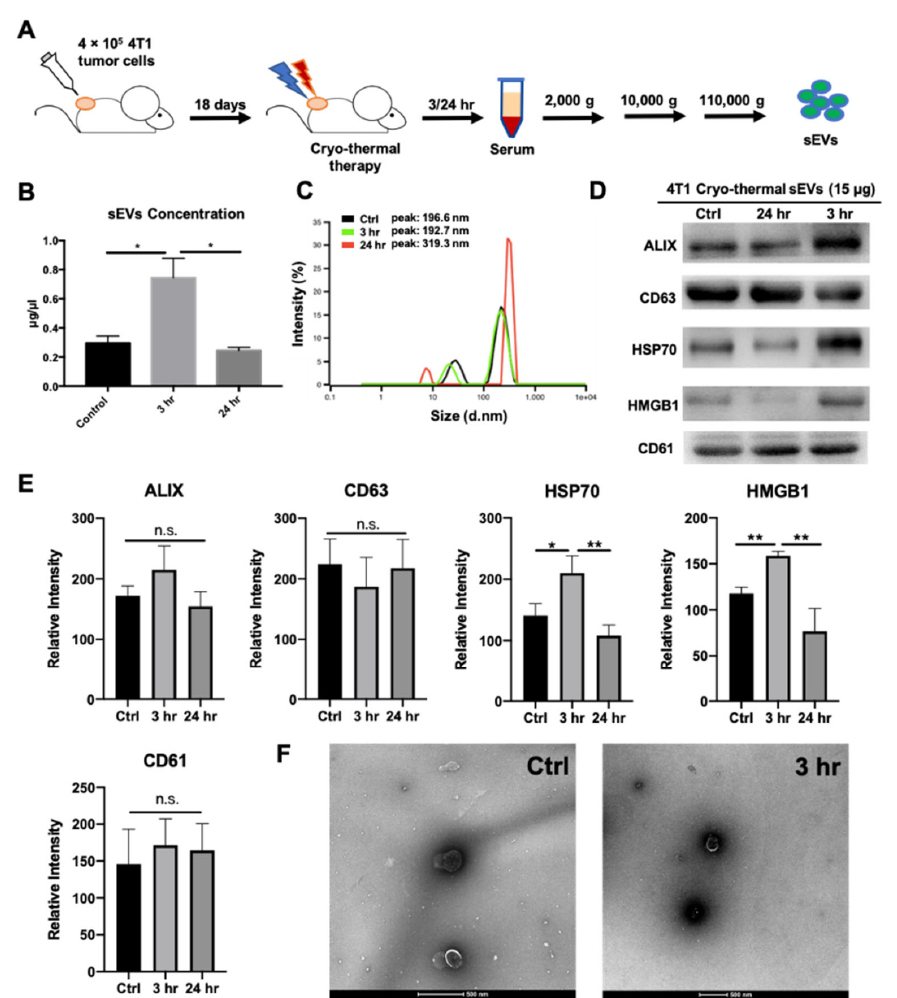
Figure 1. Isolation and characterization of serum extracellular vesicles (sEV) released into periphery after cryo ‐ thermal therapy. ( A ) Schematic of sEV isolation procedures. Approximately 4 × 10 5 4T1 cells were injected subcutaneously into the right flank of each mouse; 18 days after tumor inoculation, mice were treated with cryo ‐ thermal therapy. Peripheral blood was collected for serum at 3 and 24 h after treatment and sEVs were isolated by differential centrifugation. ( B ) Protein concentration of sEVs after cryo ‐ thermal therapy was measured with BCA assay. ( C ) Particle size distribution of sEVs isolated from tumor ‐ bearing or cryo ‐ thermal ‐ treated mice at 3 or 24 h after cryo ‐ thermal therapy. Intensity weighted z ‐ average diameters were measured using dynamic light scattering (DLS). ( D , E ) Western blotting of sEVs (15 μ g) at 3 and 24 h after therapy with individual densitometry analysis. ALIX, CD63: exosomal protein markers; HSP70, HMGB1: danger signals; CD61: platelet marker. ( F ) Morphology of sEVs isolated from tumor ‐ bearing or cryo ‐ thermal ‐ treated mice at 3 h post treatment. Images were obtained using transmission electron microscopy (TEM). Data were shown as mean ± SD, and the Student’s t ‐ test was used for statistical analysis. n = 4, * p < 0.05, ** p < 0.01.